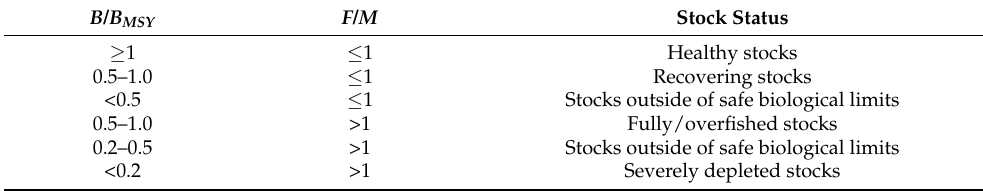
>1 Stocks outside of safe biological limits <0.2 >1 Severely depleted stocks Modified from Froese et al. [39] and Zhai et al.